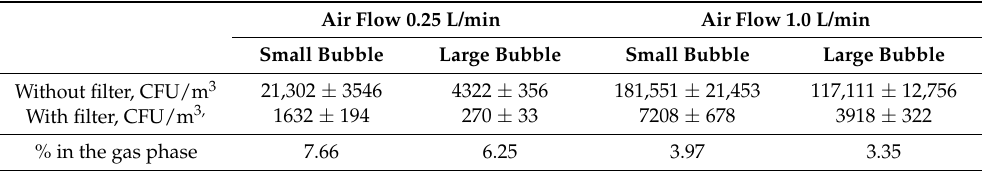
Table 1. Contribution of the bioaerosol release by the gas carrier and bursting